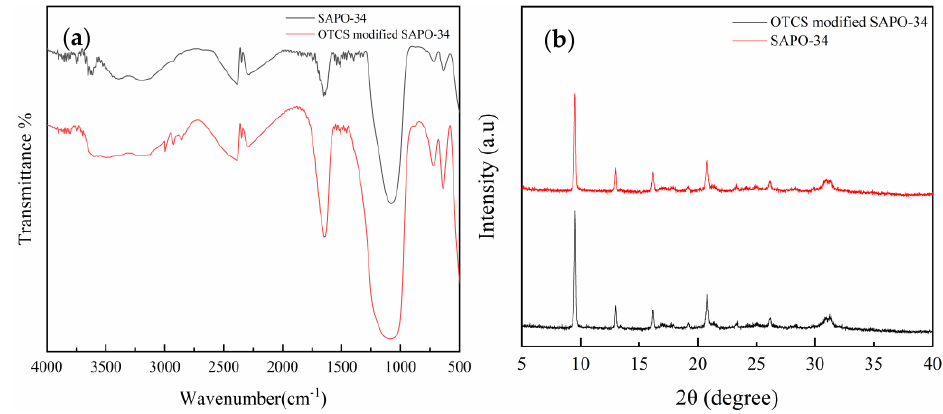
Figure 4. ( a ) FT-IR spectra and ( b ) XRD of SAPO-34 and OTCS modified SAPO-34.